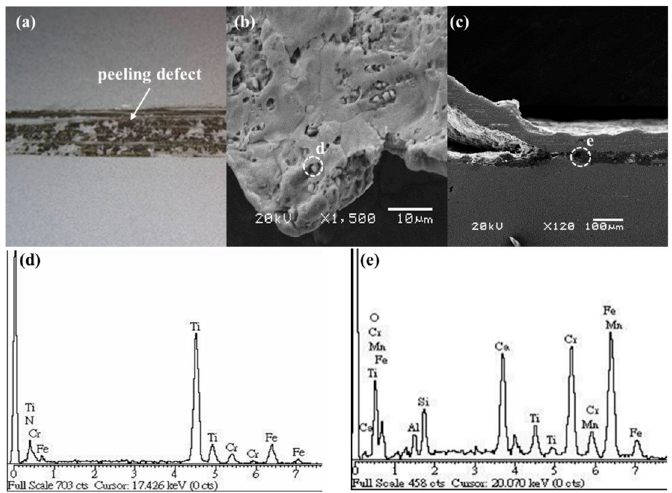
Figure 2. ( a ) Photograph of the cold-rolled TCFSS strip, SEM images of ( b ) the inner surface of the peeling defect and ( c ) the peeling defect present at the interlayer, and EDS profiles of ( d ) position “d” in ( b ) and ( e ) position “e” in ( c ).